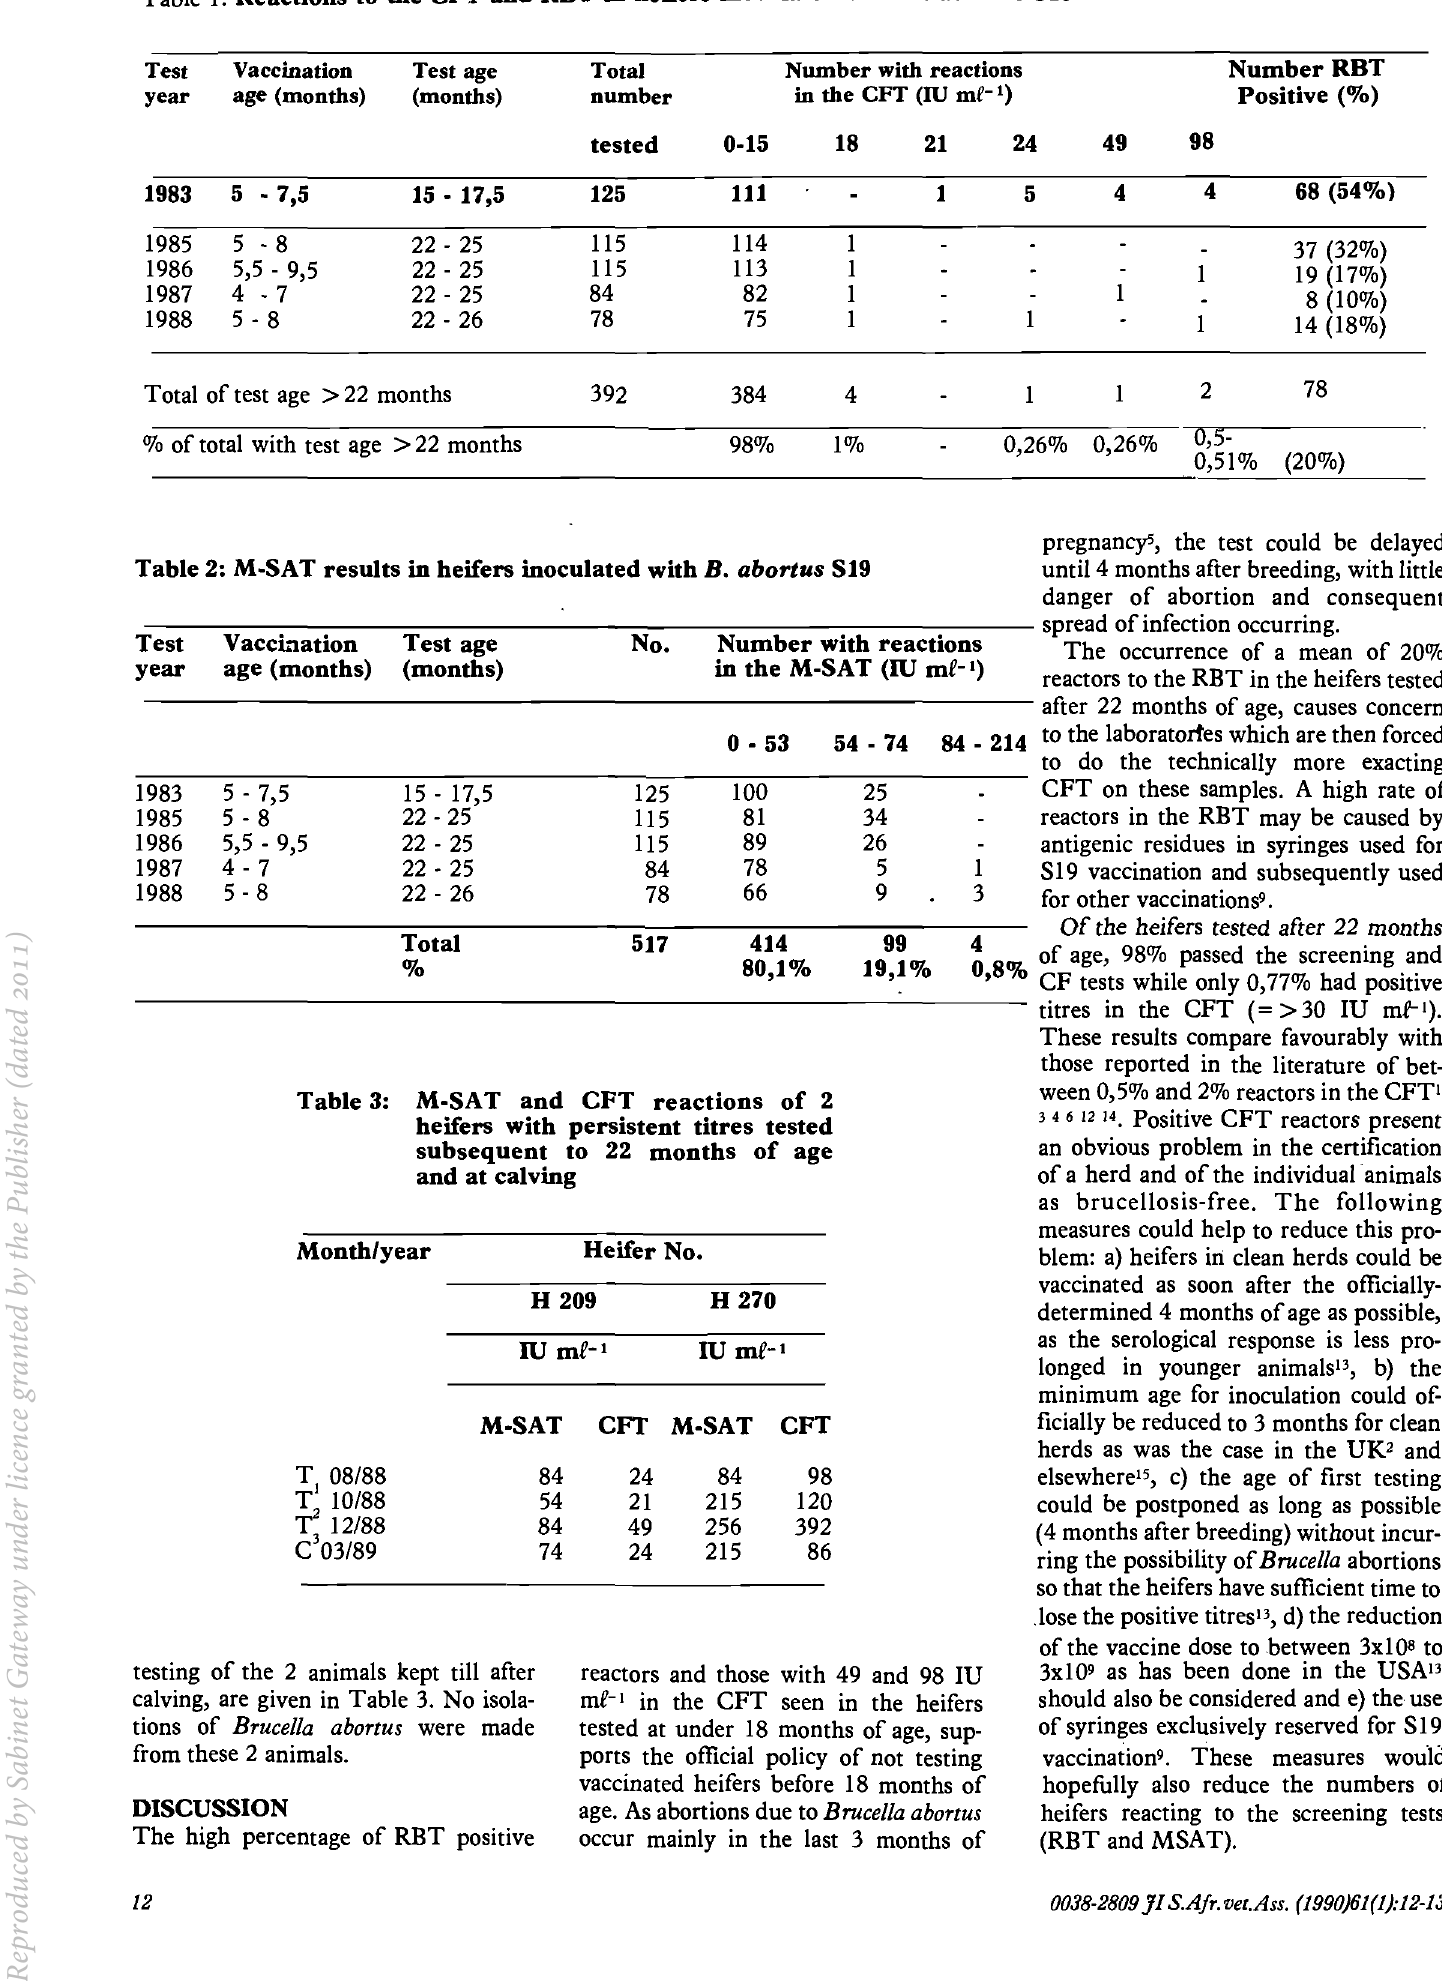
Table 1: Reactions to the CFT and RBT in heifers inoculated with B. abortus S19 Test